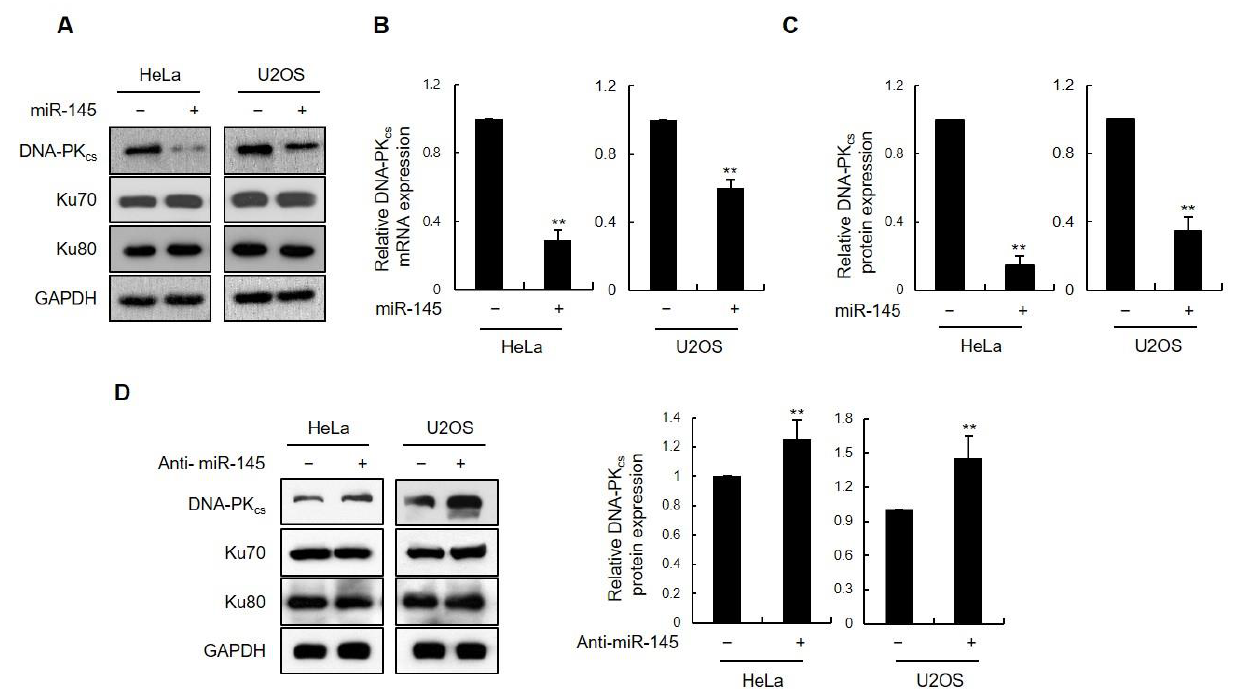
Figure 1. miR-145 negatively regulates DNA-PK cs expression in human cells. ( A ) Western blot analysis of DNA-PK cs expression in HeLa and U2OS cells 48 h after transfection with miR-Ctrl or miR-145. Ku70 and Ku80 protein levels were measured as negative controls. ( B ) Relative expression levels of DNA-PK cs mRNAs were detected 48 h post-transfection and quantified using quantitative RT-PCR. The RT-PCR signal is normalized to that of the housekeeping gene GADPH. Data represent the mean ± standard deviation (SD) ( n = 3); **, p < 0.01. ( C ) Quantification of DNA-PK cs western blot signals from three independent experiments as performed in ( B ) using Sicon image software. DNA-PK cs protein levels were normalized using Ku70 protein levels (control). Data represent the mean ± SD ( n = 3); **, p < 0.01. ( D ) Western blot analysis of DNA-PK cs levels in U2OS and HeLa cells 48 h after transfection with the control or miR-145 inhibitor. The band intensities of DNA-PK cs and Ku70 immunoblots were quantified using Sicon image software and the relative DNA-PK cs protein levels were normalized to those of the control and represented as mean values from three independent experiments.